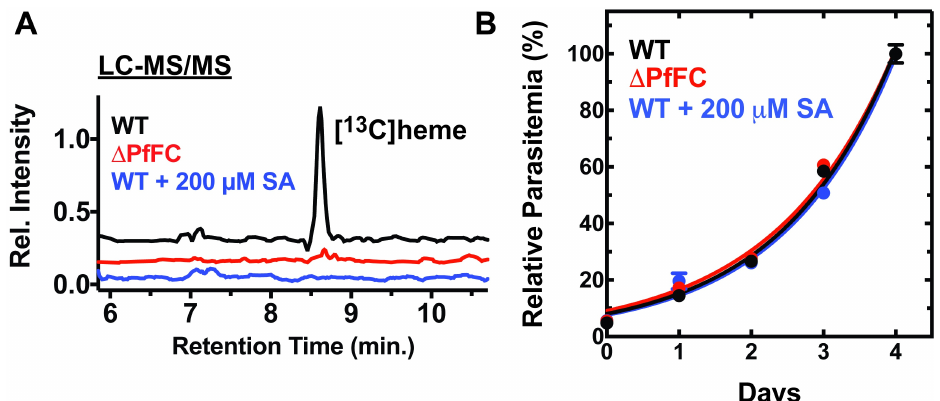
Fig 2. Ablating heme biosynthesis has no effect on blood-stage P . falciparum growth. (A) Mass spectra (from [12])for detectionof [ 13 C]hemebiosynthesizedfrom 13 C 4 -ALA in WT P . falciparum D10 parasites, Δ FC parasites,or WT parasitesgrownin 200 μ M SA. Spectra werenormalizedto the intensity of the heme peak in the WT parasitesampleand offset to avoid baseline overlap.(B) Growth of asynchronous WT or Δ FC D10 parasitesin the absenceor presenceof 200 μ M SA (from [13]).Measuredparasitemia valuesfor each parasite line were normalized to the respectiveparasitemia on day 4 andfit with an exponential growth equation. Abbreviations: Δ PfFC, geneticknockoutof P. falciparumferrochelatase; SA, succinylacetone;WT, wild-type.